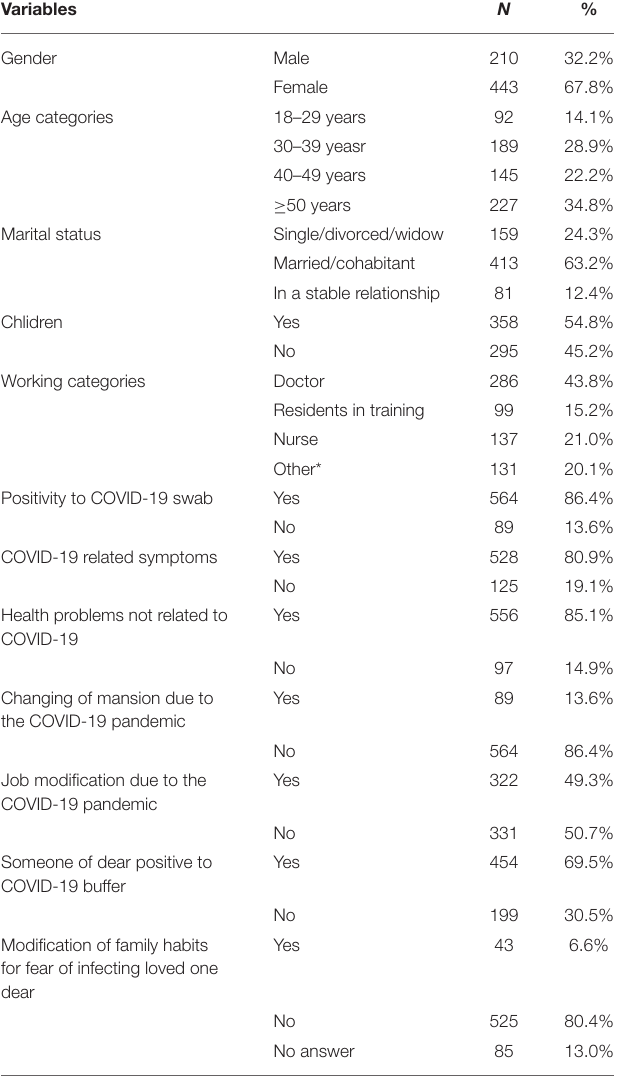
TABLE 1 | Descriptive data of the sample, including socio-demographic and work related variables. Variables